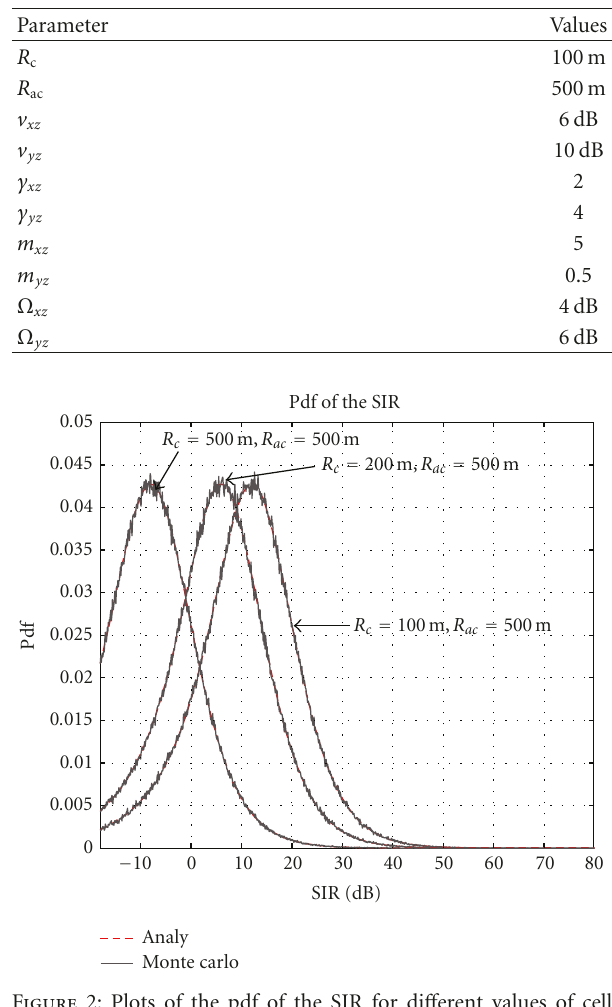
Figure 2: Plots of the pdf of the SIR for di ff erent values of cell radius.